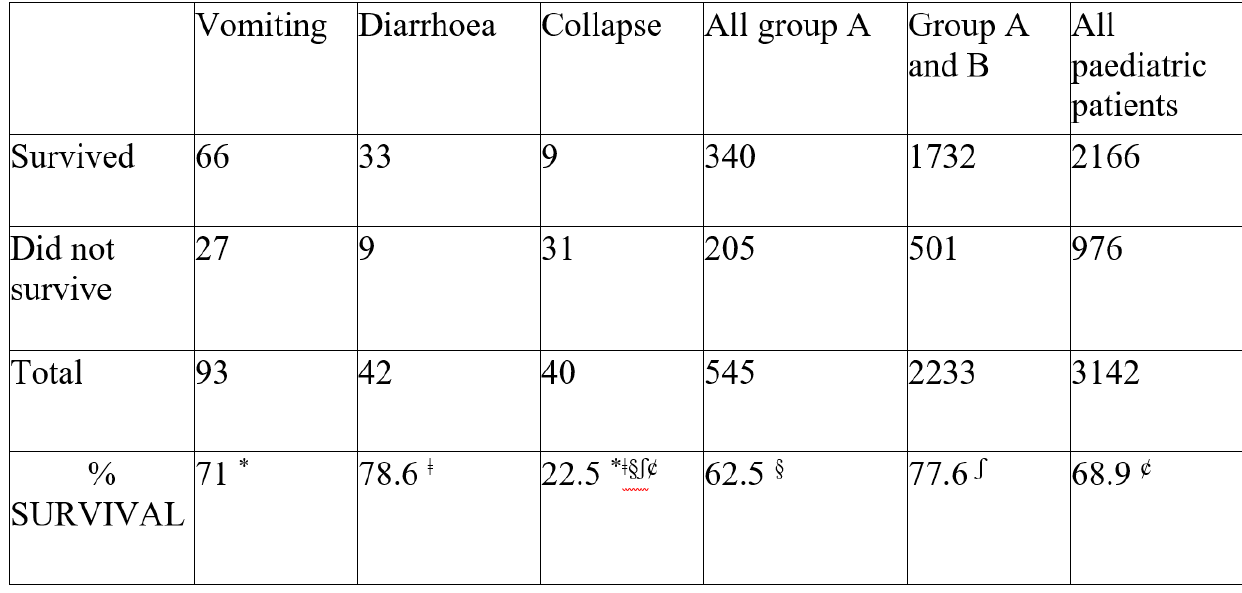
Table 2: Outcome recorded for the three most common presentations for the canine patients < 3months old who attended the clinic and followed veterinary advice. Categories indicated by matching symbols (* ǂ § ʃ ¢) indicate pairs where survival was significantly